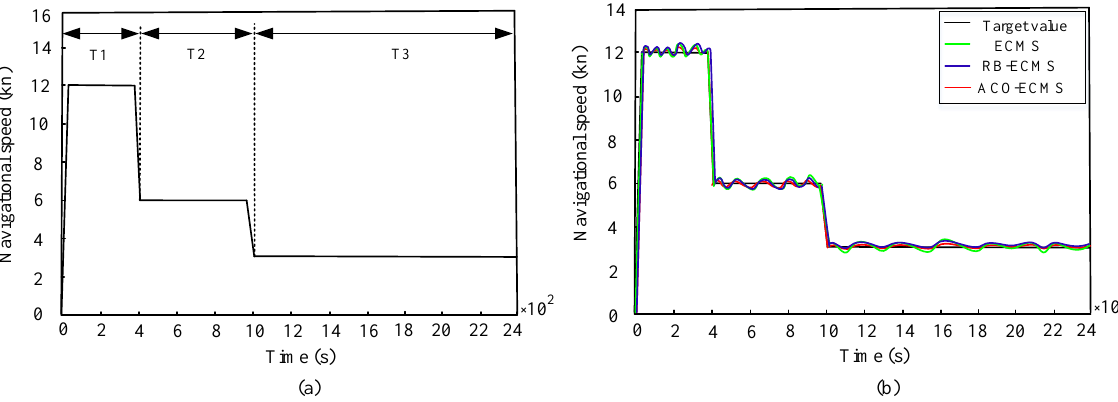
Figure 9. ( a ) A complete fishing operation condition (T). ( b ) Simulation results of speed under the T condition.